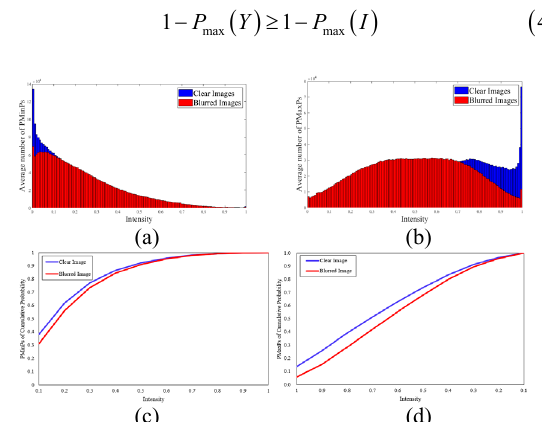
Figure 1. Statistics of the minimal and maximal pixels in clear and blurred images over 10,000 natural images, patch size is 35 35 × where “1” presents the maximal value of the PMaxPs.